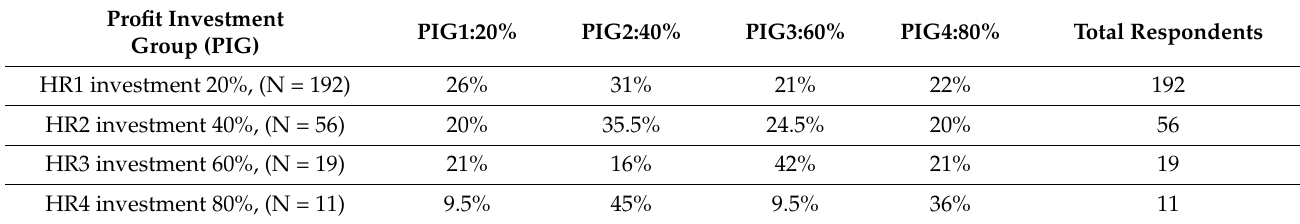
Table 2. Investment portfolio based on HR investment share.